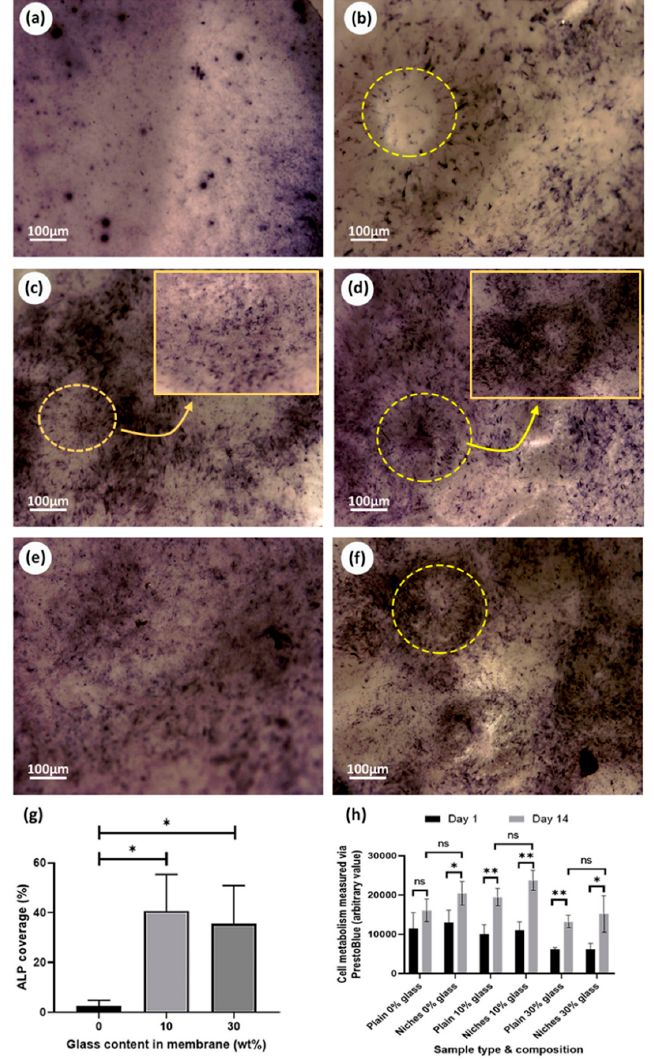
Figure 9. Biological evaluation of scaffolds functionalized with BG. ALP assay pictures: ( a ) plain sample 0% BG; ( b ) niche sample 0% BG; ( c ) plain sample 10% BG; ( d ) Niche sample 10% BG; ( e ) plain 30% BG; ( f ) niche sample 30% BG; ( g ) ALP quantification for niche samples obtained by calculating